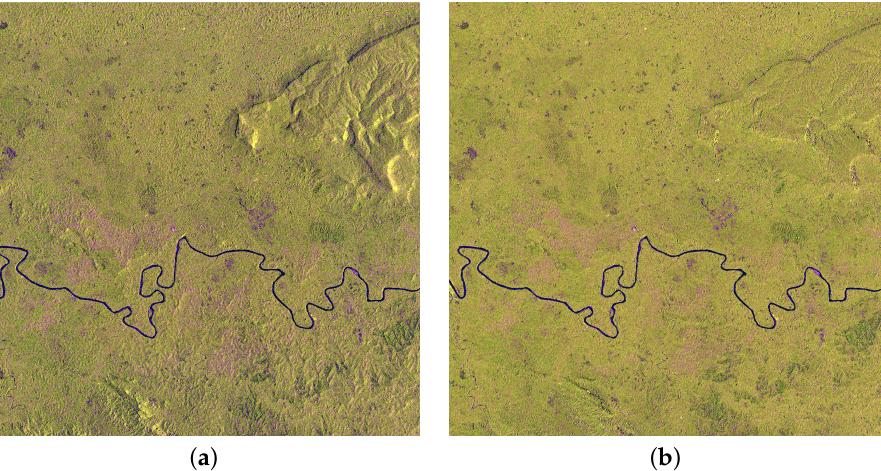
Figure 4. RGB visualization of a dual polarized (VV and VH) Sentinel-1 SAR backscatter image of central Borneo, Indonesia (Lat: − 0.35, Lon: 112.15) ( a ) as ingested into the Google Earth Engine; and ( b ) after applying additional border noise removal, a 9 × 9 multi-temporal Gamma MAP speckle filter and radiometric terrain normalization with a volume scattering model. Here VV is in red, VH is in green, and VV/VH ratio is in